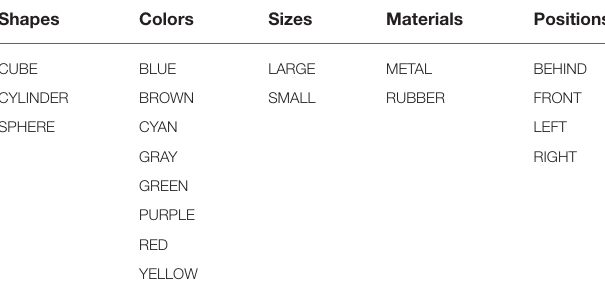
TABLE 1 | All concepts in the experimental